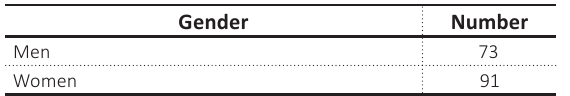
Table 2. Demographic